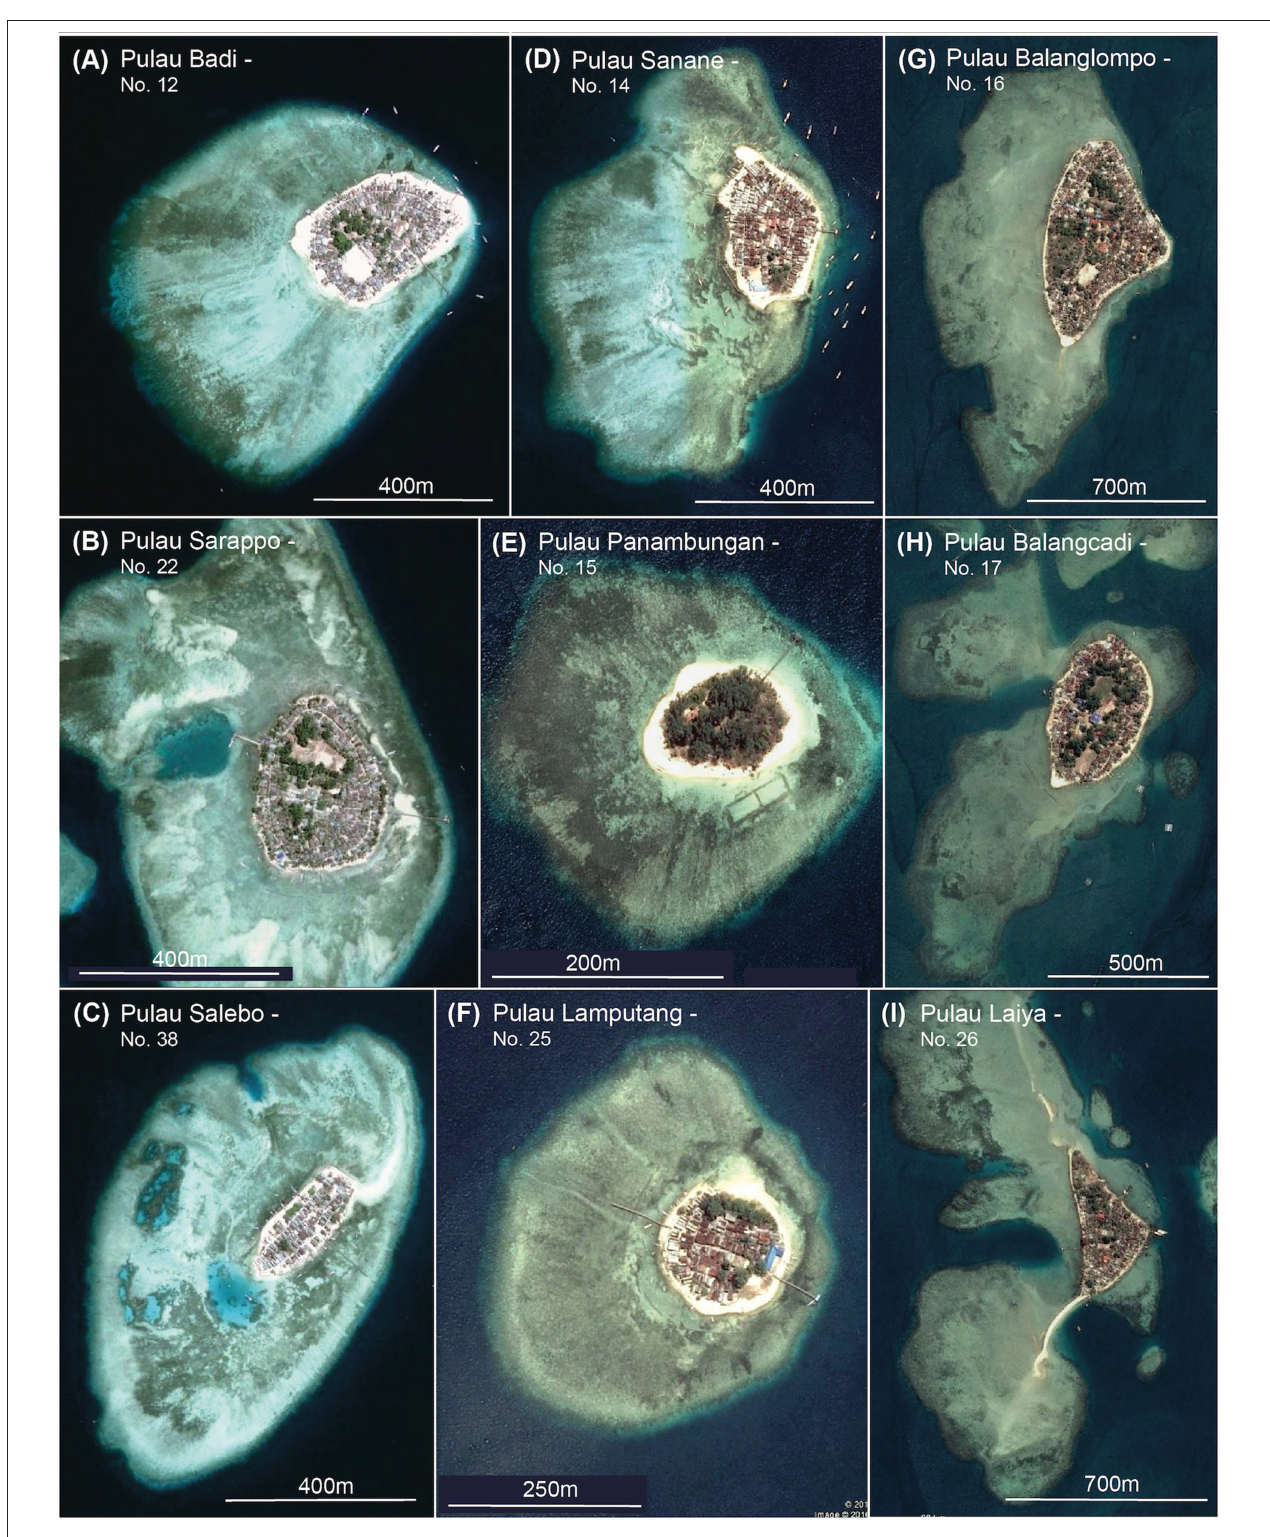
FIGURE 6 | Examples of reef island planform shape and location on reef surfaces on the outer rim (A–C) , mid-shelf (D–F) , and inner shelf (G–I) . Note number of islands with anthropogenic modification. Location of islands shown in Figure 2 and size of islands presented in Table 1 . Numbers below island names refer to Table 1 and Figure 2 (Satellite images from Google TM , © 2017 DigitalGlobe).